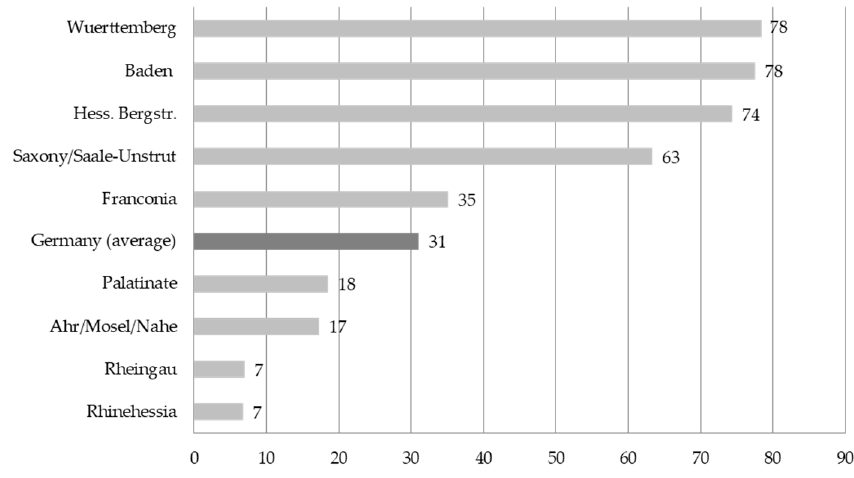
Figure 5. Regional penetration of cooperatives (% of vineyard surface) [95].